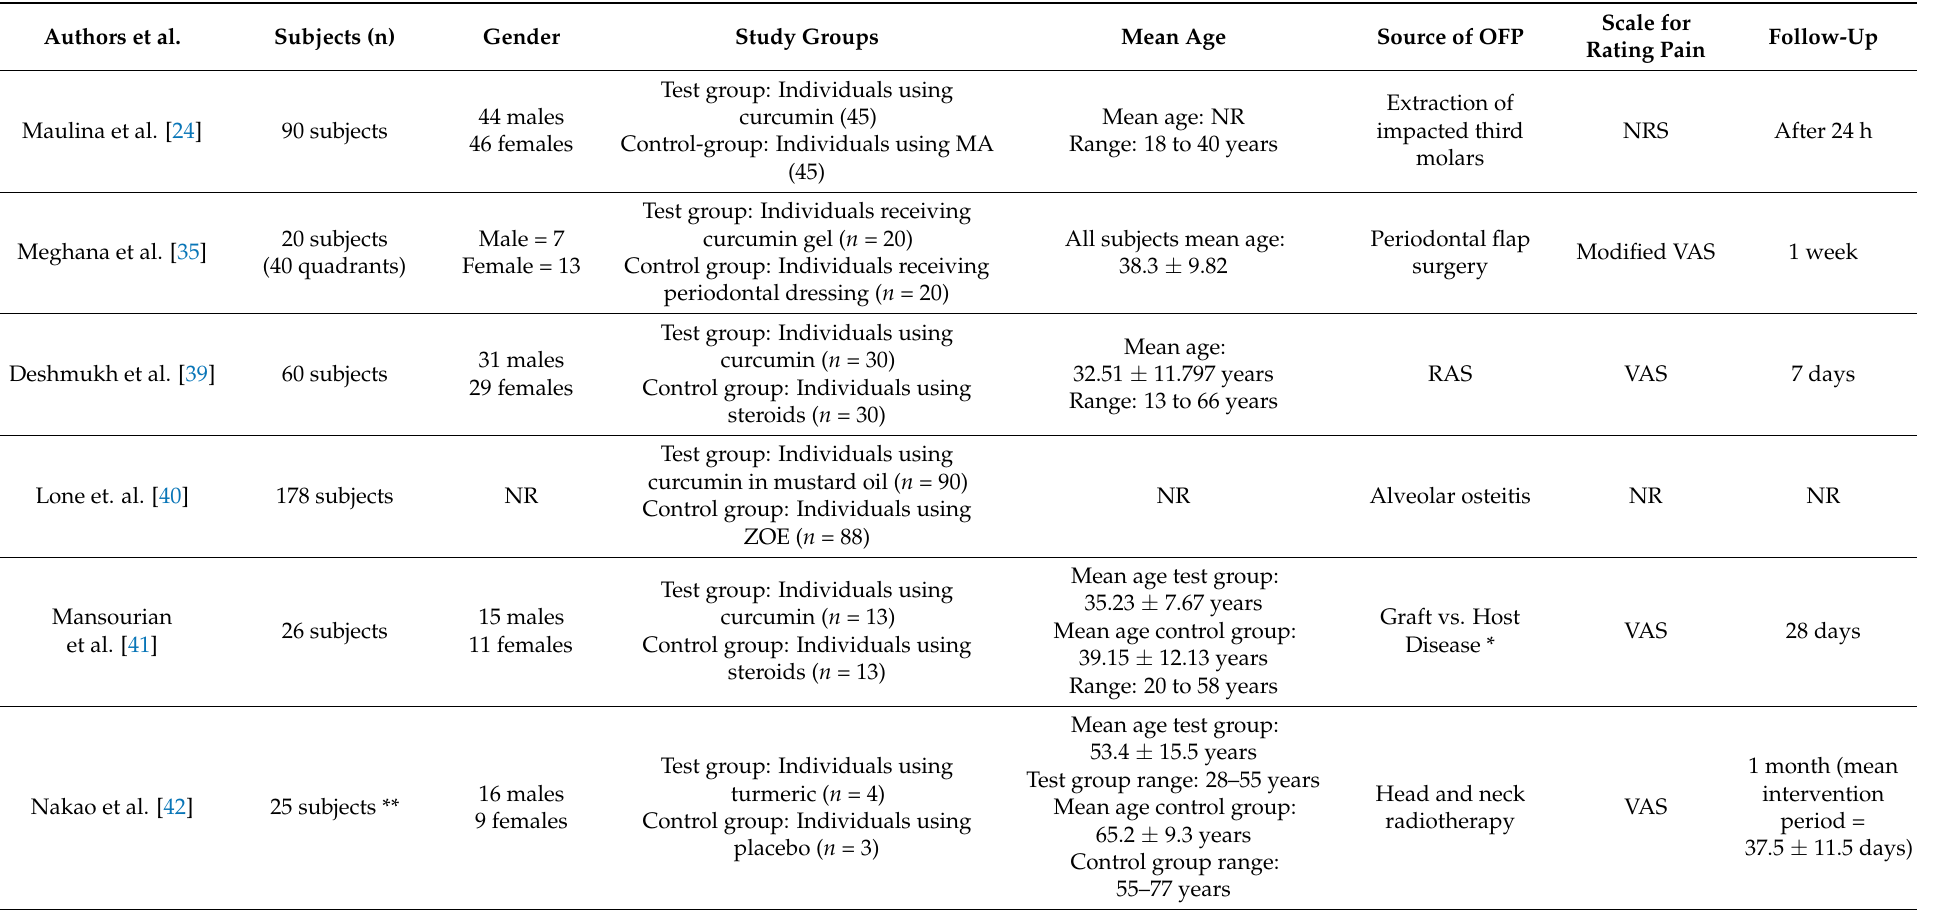
Table 1. General characteristics of the included randomized controlled